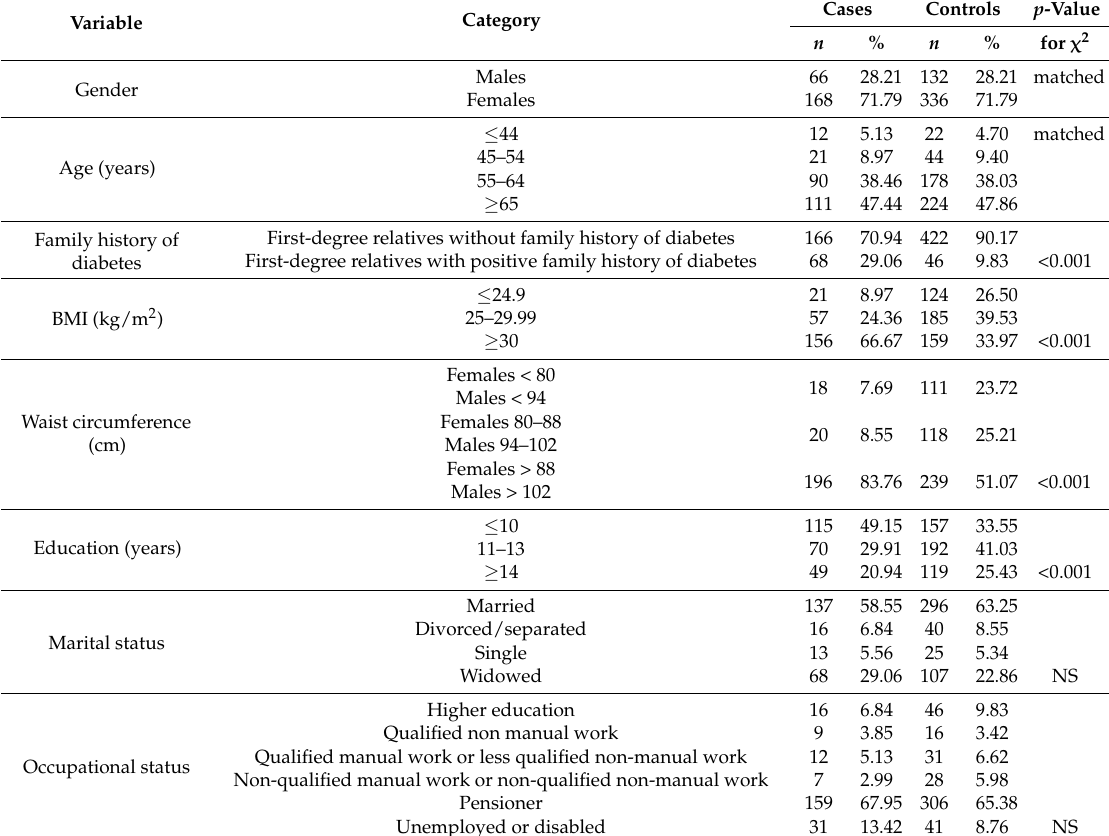
Table 1. Characteristics of cases and